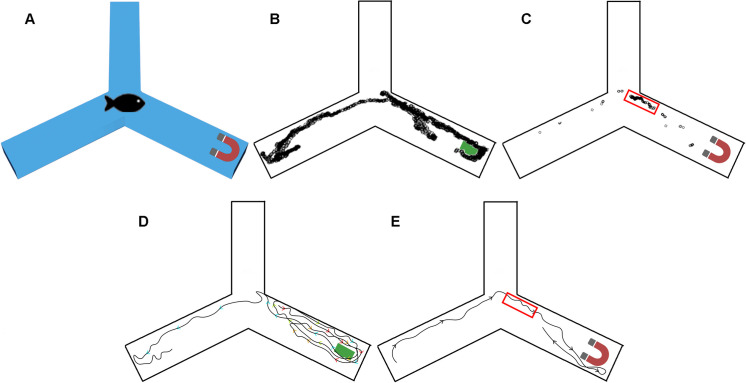
DeepLabCut tracking of a single fish.A) Experimental set up. B) Sham, C) Magnet. The fish position is shown here over every frame for 170 s (5,100 frames). Indivudual values were exported and plotted using R and overlaid on a Y-maze diagram. D) Directional tracing of sham experiment. E) Directional tracing of magnet experiment. The red box on B and E represents the area where the fish spent 77% (131 seconds) of its time during the magnetic trial. The movment down the two arms were rapid, resulting in less total visible dots.